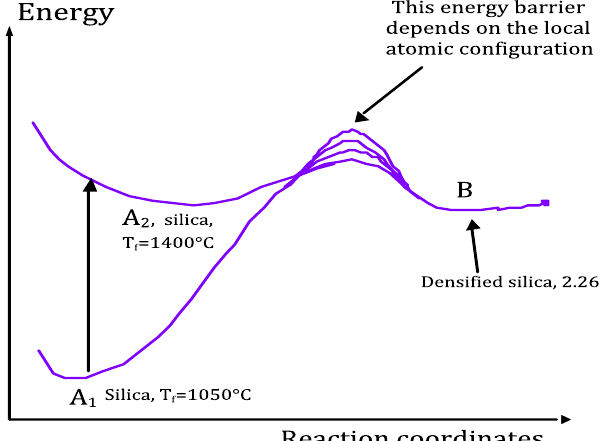
Figure 9. Chemical pathway between a pre-densified silica A and the final B state. Example of the influence of initial fictive temperature T f